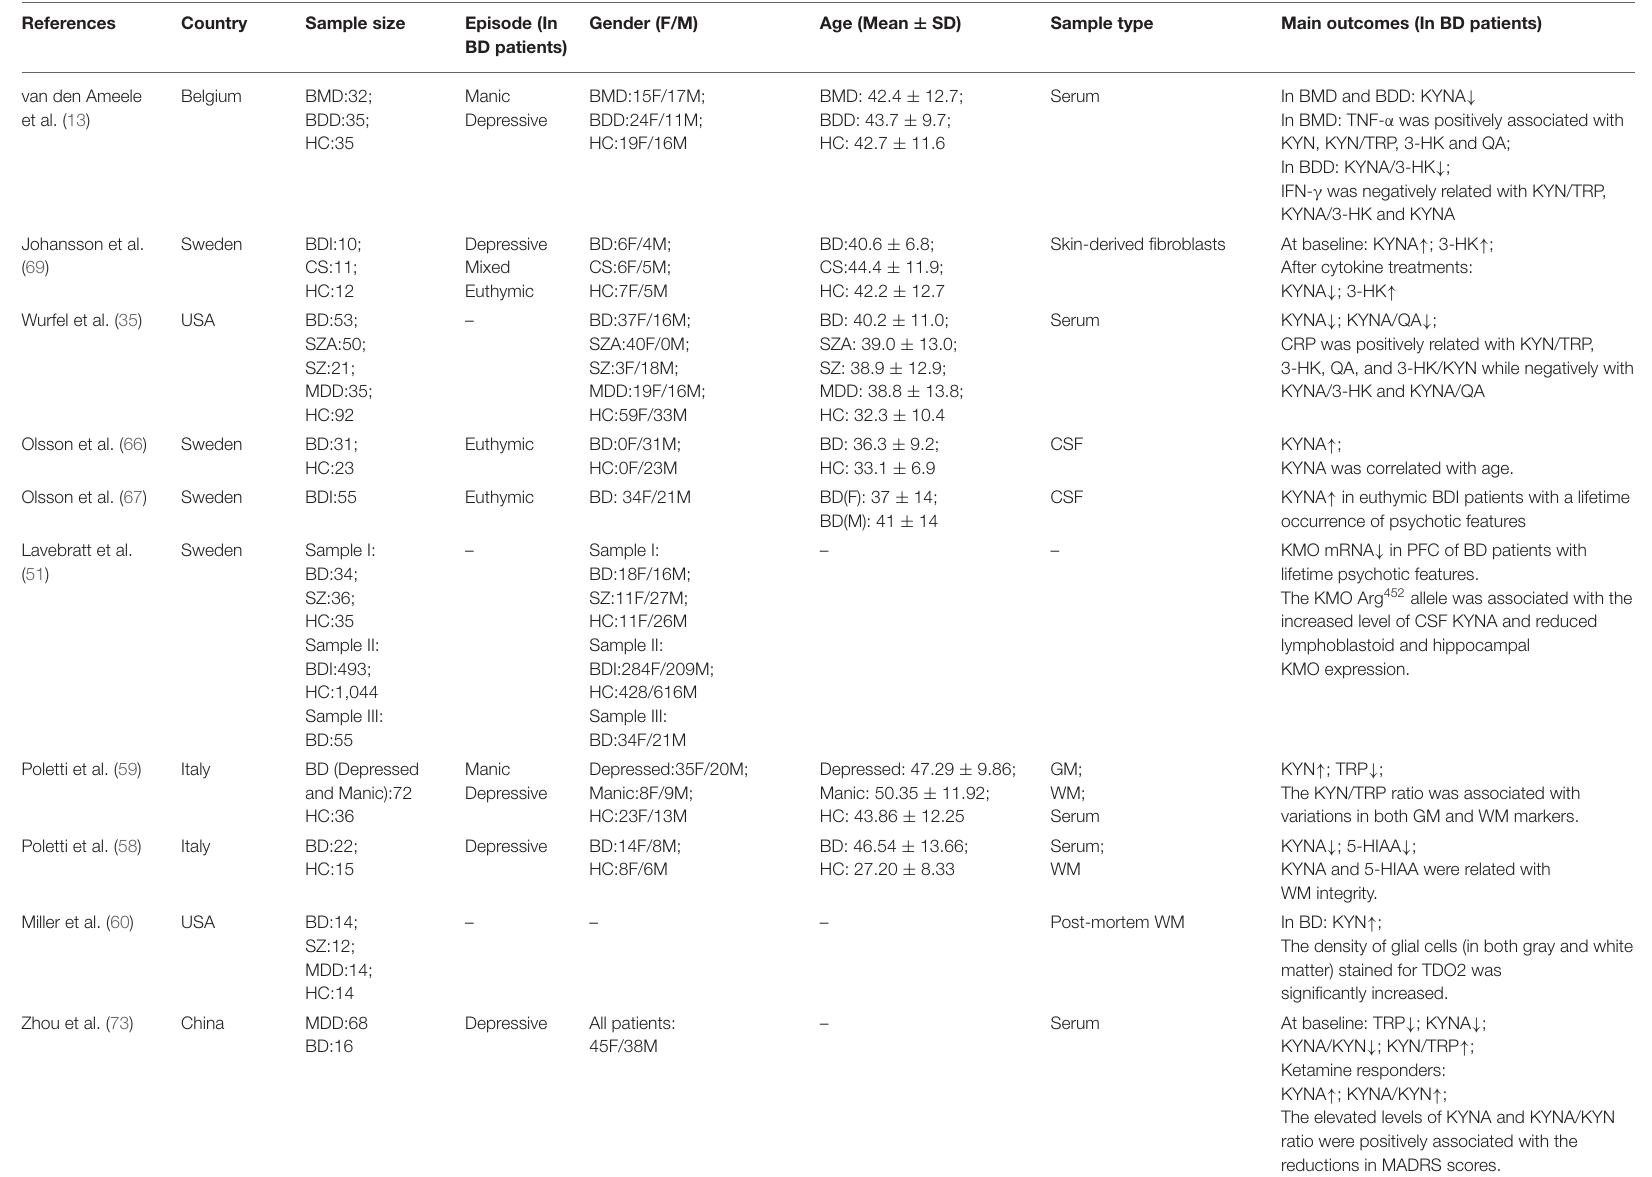
TABLE 1 | Demographic characteristics and findings of included studies on the KYN pathway in